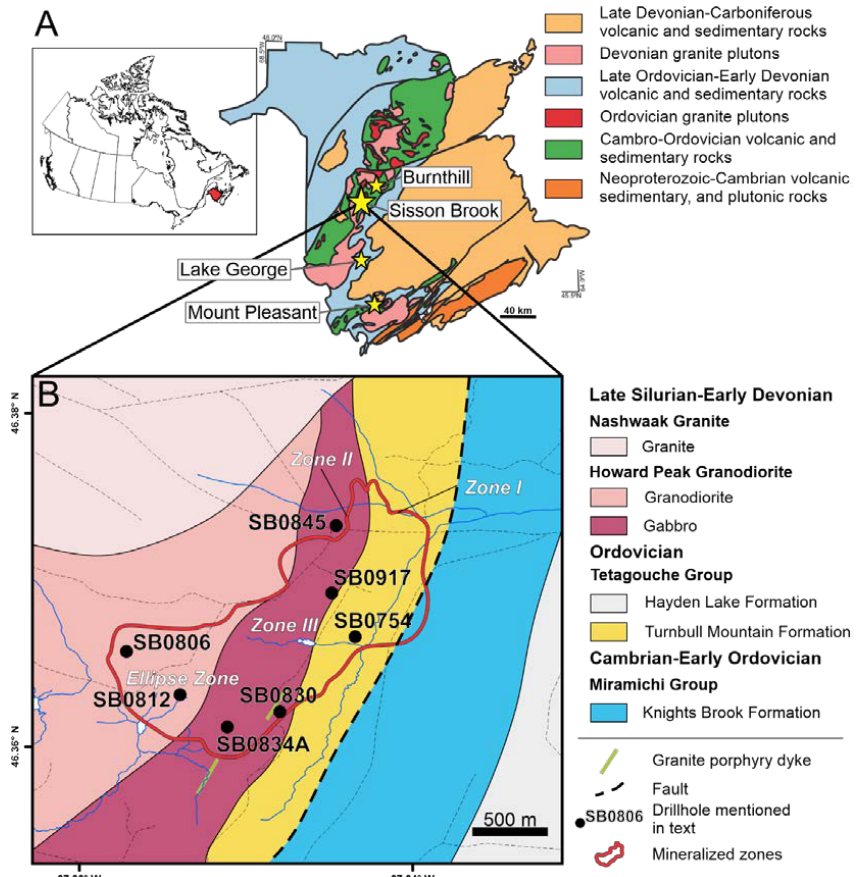
Figure 1. ( A ) General geology of New Brunswick (eastern Canada) with inset showing location of New Brunswick in Canada. Major Sn-W-Mo-Sb +/ − Au deposits associated with Silurian to Devonian granitic plutons denoted by stars. Geology after Stewart et al. [17]. ( B ) Local geology of the Sisson Brook Deposit (outlined in red) with mineralized zones and collar locations of selected drill cores mentioned in text. Geology and mineralized zones modified from Rennie [20], which is modified after Fyffe et al. [25].